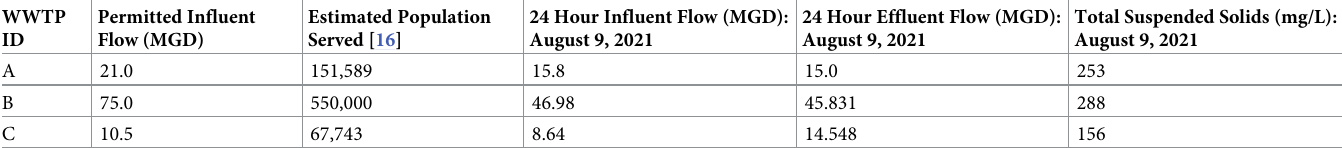
Table 1. Permitted flow, population size served, and 24-hour influent and effluent flow on the day of sample collection for the three WWTP in this study. See S1 Table in S1 File for metric conversions of million gallons per day (MGD). WWTP